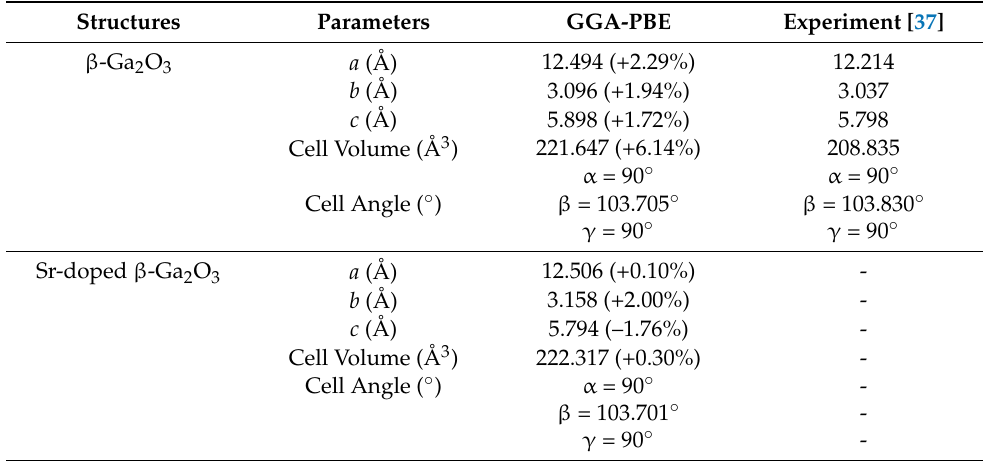
Table 1. Calculated lattice parameter ( a , b and c ), cell volume, and cell angle for pure and Sr-doped × 1 × 1 unit β -Ga 2 O 3 crystal structure in 1